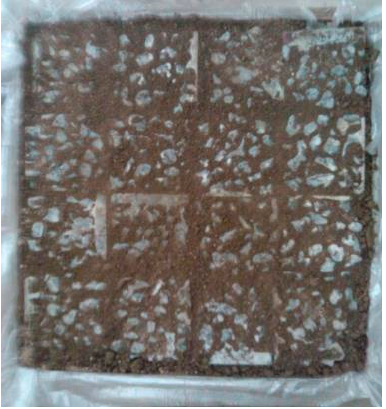
Figure 6. Vegetation-pervious concrete filled with mulching materials.